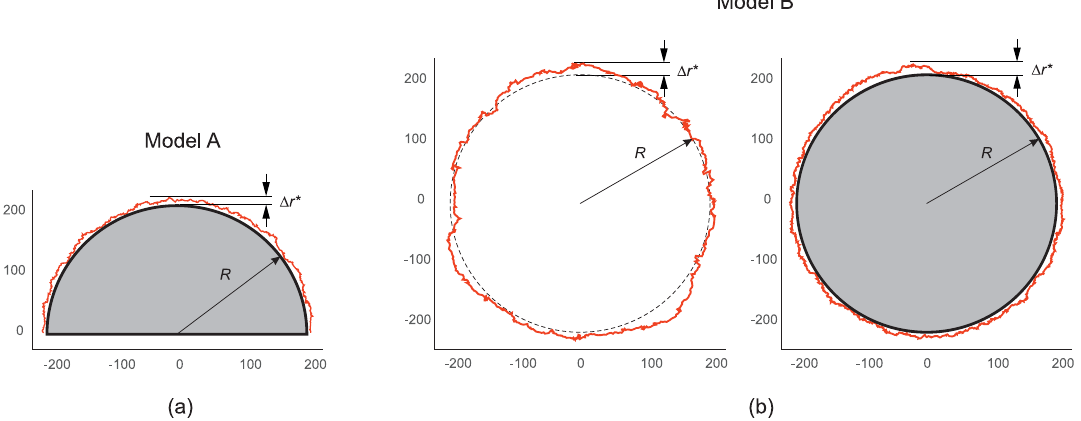
Figure 1 . Models A and B of stretched paths above the impenetrable circular domain: (a) in the model A stretching is ensured by imposing by hands condition L = cR on the relation between the disc radius and the path length; (b) In the model B the random loop is strongly inflated with a large algebraic area, as it is shown by dotted line in the left panel of figure (b), and then inside the inflated loop the impenetrable disc of the radius R is inserted such that the path is leaning on a disc boundary as it is shown in the right panel of figure